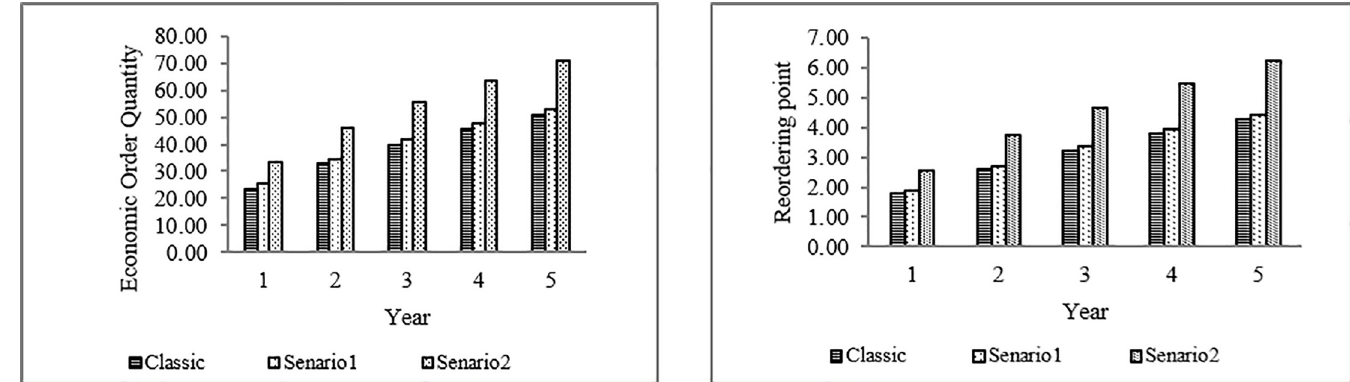
Fig 5. The amounts for re-order shipping and the economic order quantities of